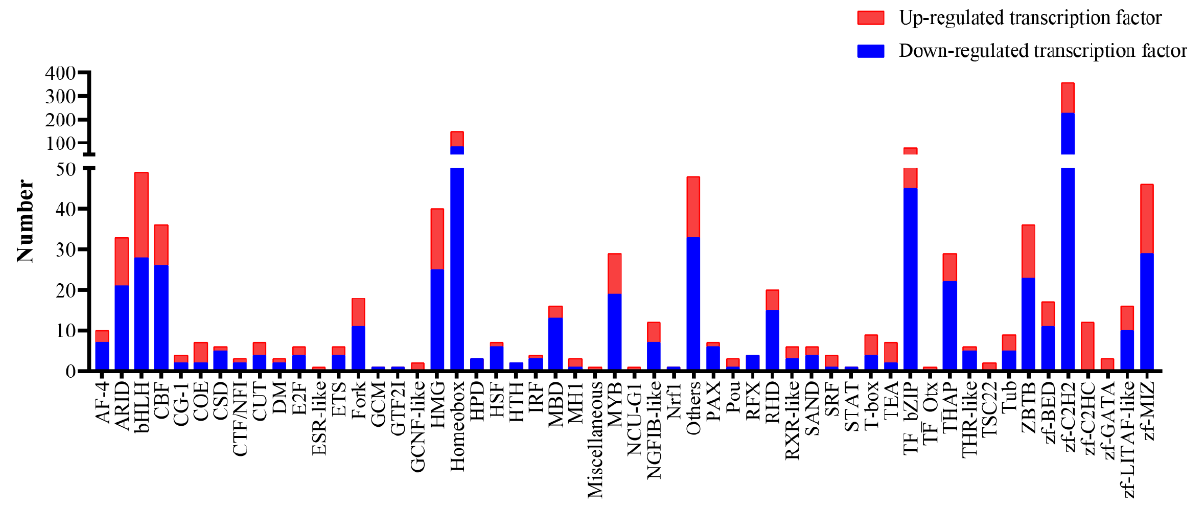
Figure 6. Differentially expressed transcription factor genes. Red boxes highlight the transcription factor families with large differences.